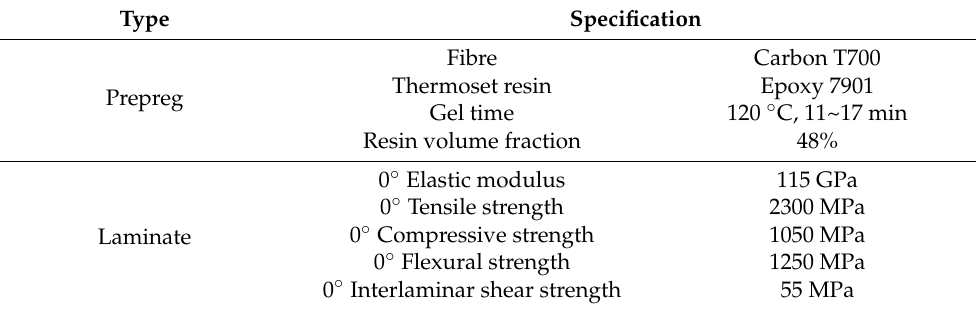
Table 1. Mechanical properties of a unidirectional carbon prepreg before and after curing.